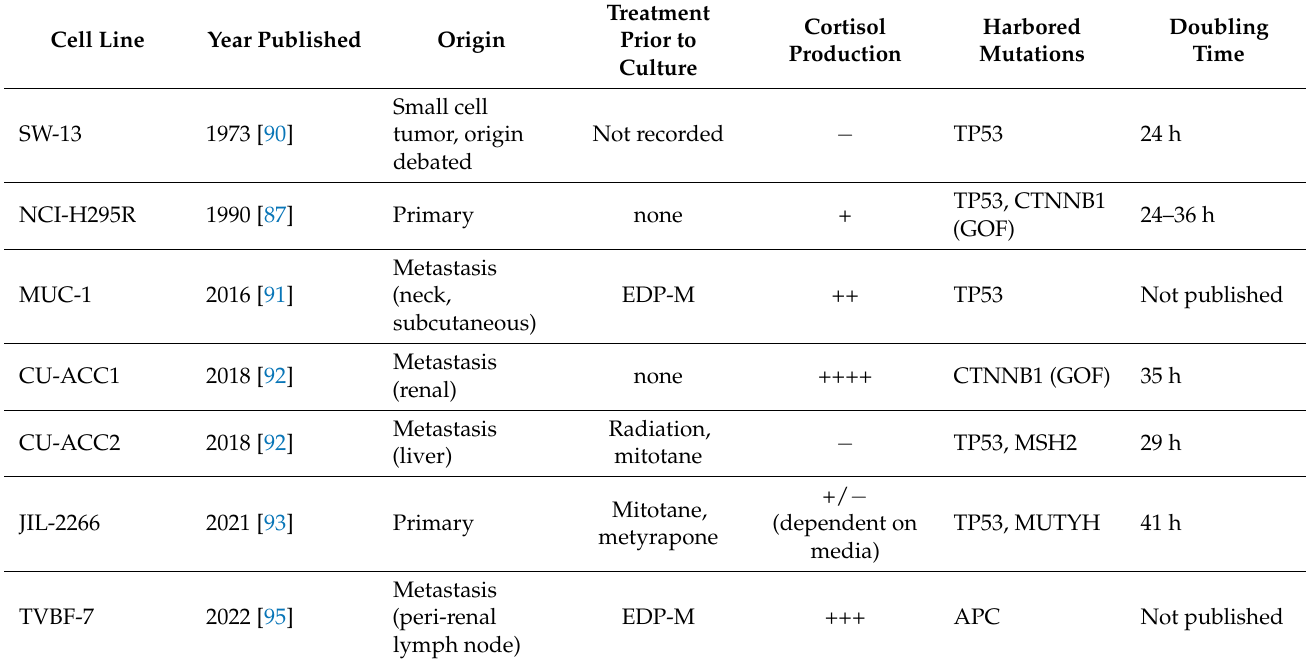
Table 2. Currently available cell lines for the study of ACC. GOF = gain of function. A ( − ) means there is no cortisol production. A (+) indicates cortisol production, and multiple (+) signs approximate increased cortisol production compared to the NCI-H295 cell